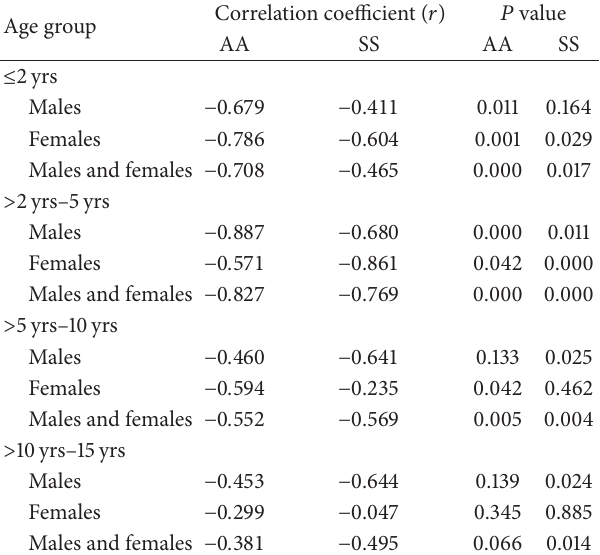
Table 2: Correlation analysis between height and Cormic Index in study subjects.